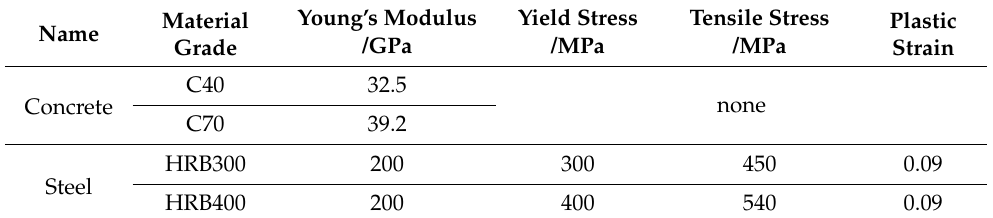
Table 3. Material properties of the structural model.